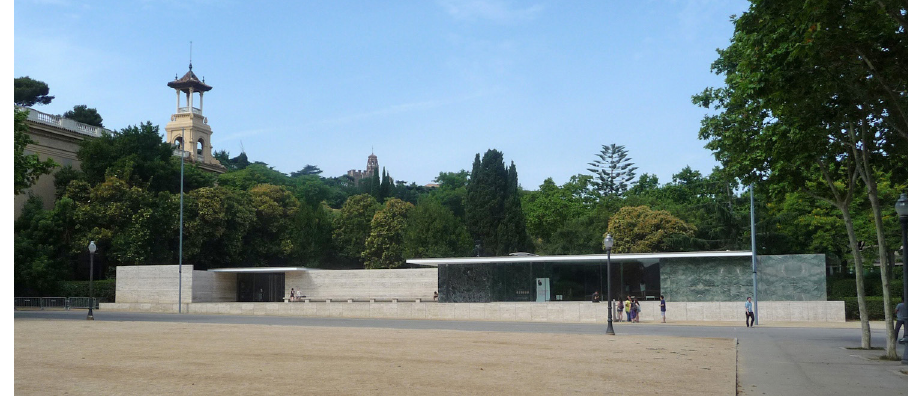
Figure 3. Abstracting the form. Pavilion in Barcelona by Mies van der Rohe (source: author, 2013)